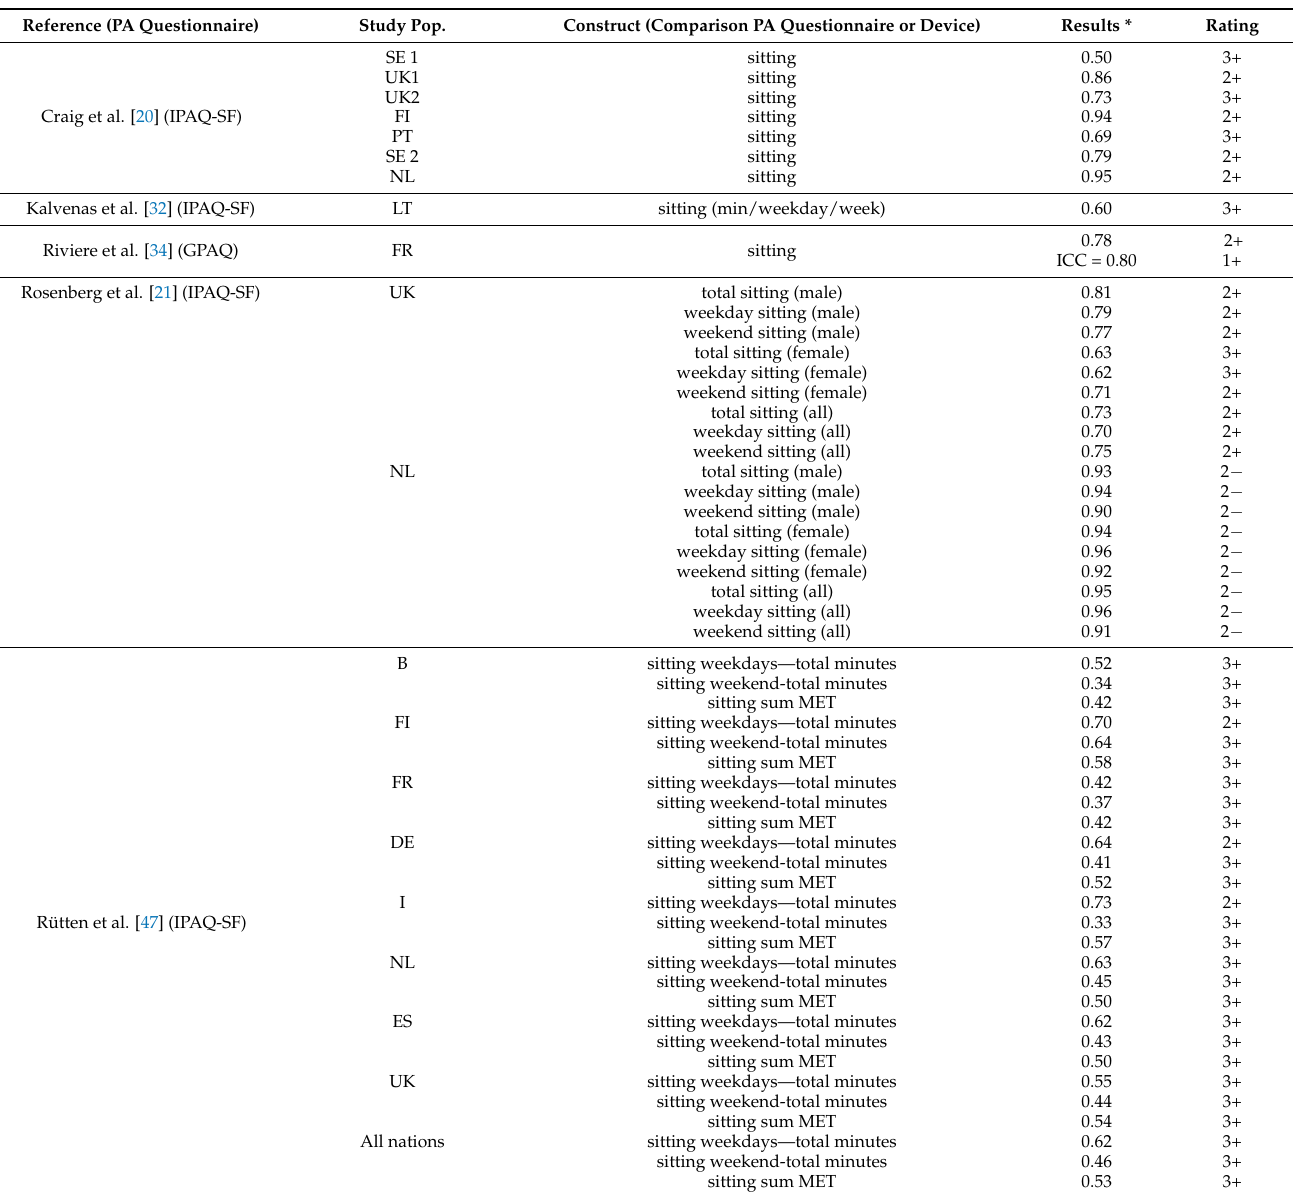
Table 3. Results for test–retest reliability for SB in selected